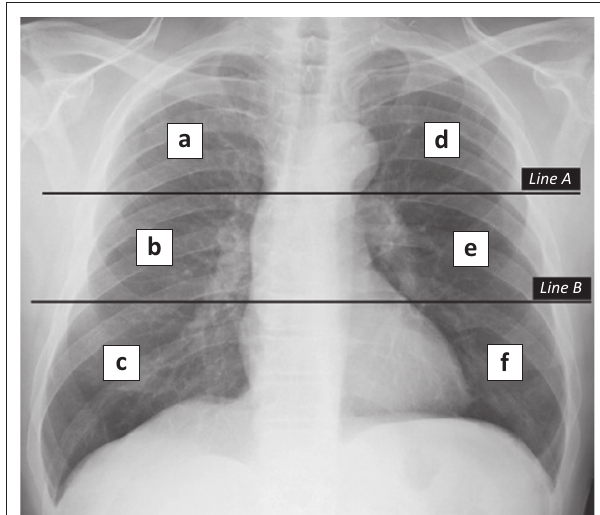
FIGURE 1: Division of lungs into six zones on frontal chest